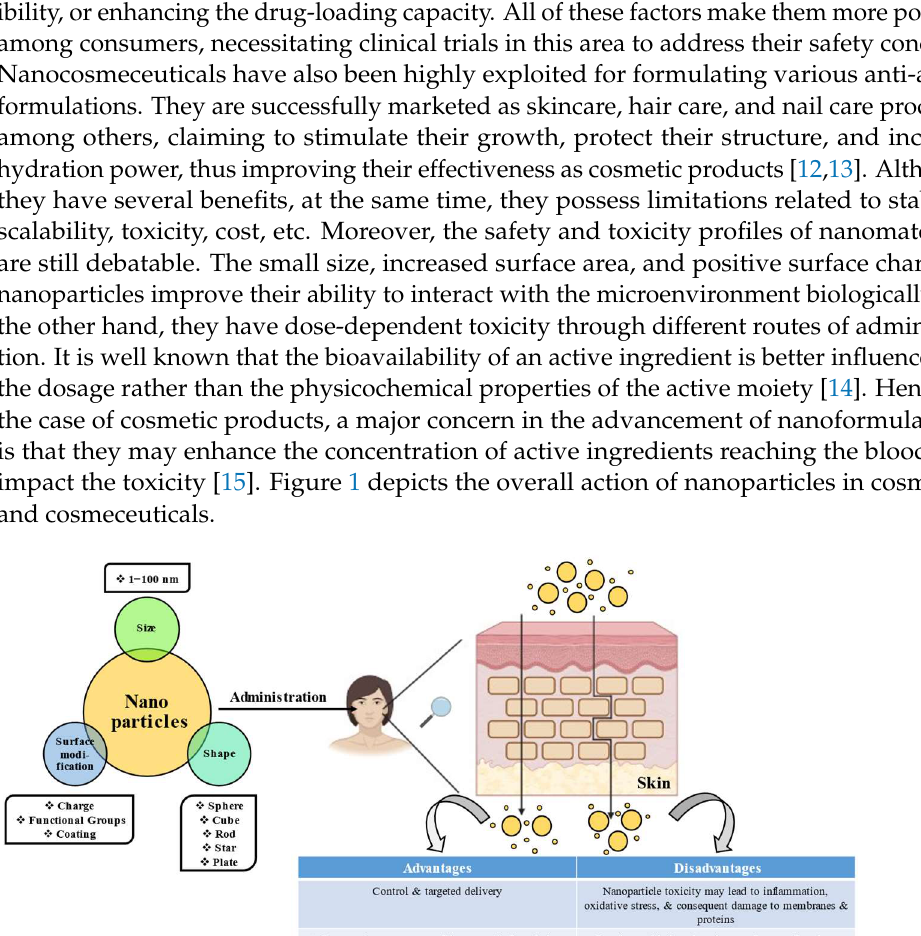
Table 1: Various nanomaterials used for preparing cosmetics and cosmeceuticals 195